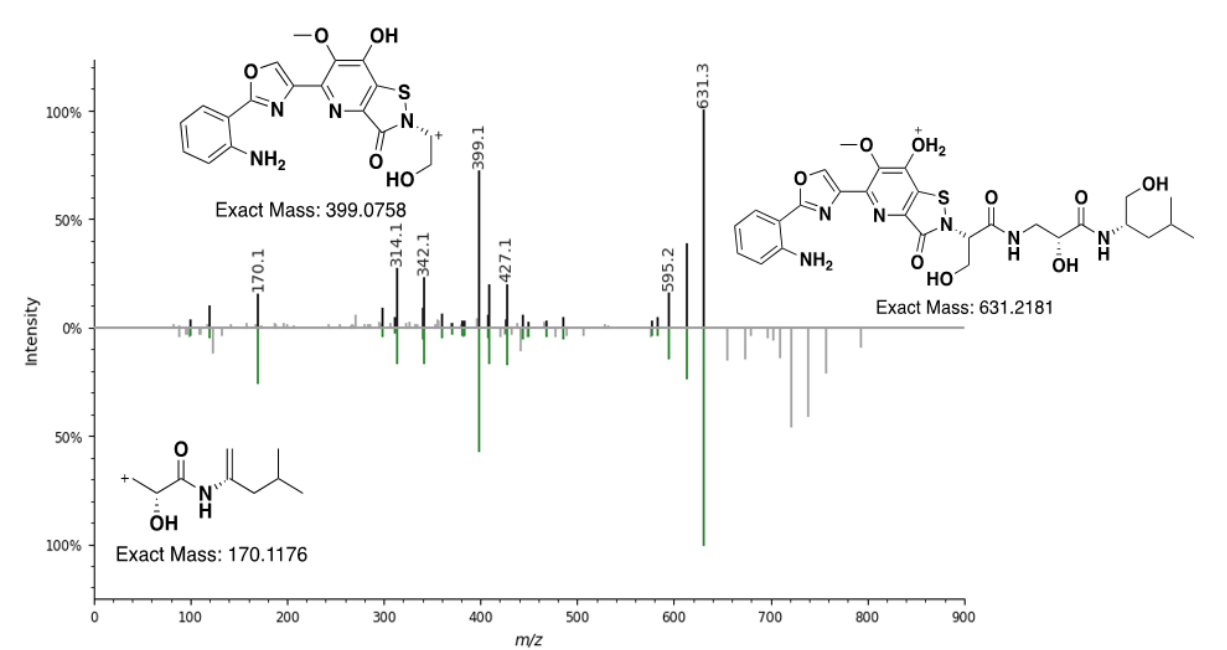
Figure 5. Mirror plot comparison of the MS 2 fragmentation for Levesquamide A ( top ) and levesquamide B ( bottom ) including diagnostic fragments 399 and 170 m/z fragments.